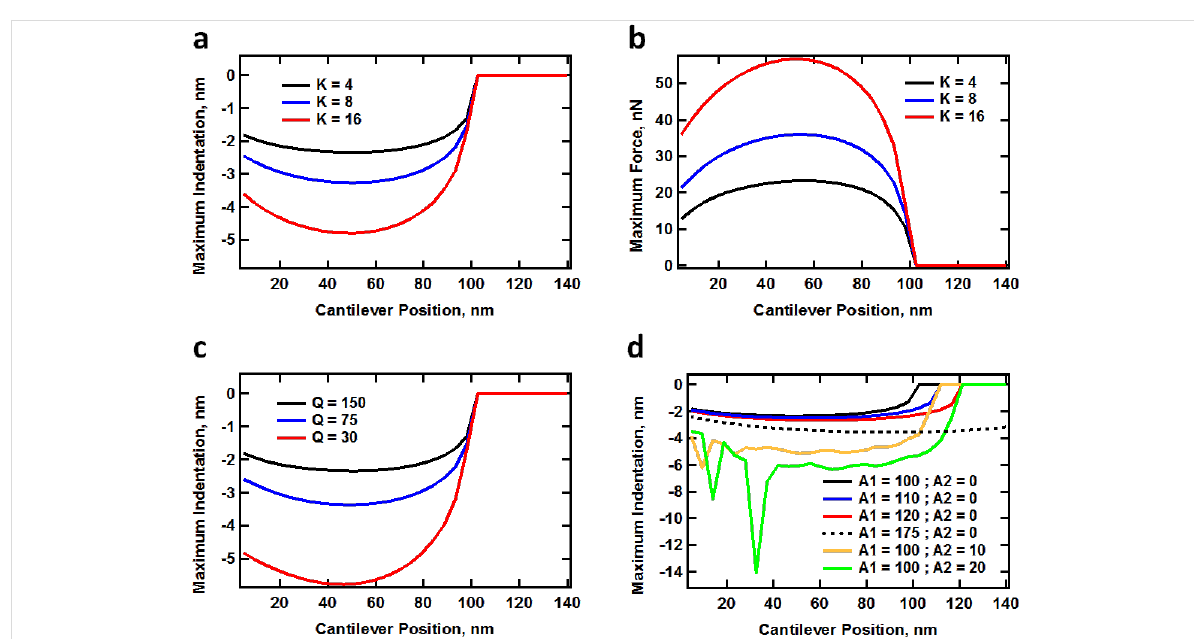
Figure 2: Simulations of maximum indentation and peak force (see section Methods below for details on the numerical simulations of the cantilever dynamics as well as the tip–sample force model used): (a) maximum indentation depth vs cantilever force constant; (b) peak forces corresponding to (a); (c) maximum indentation vs cantilever quality factor, Q (unrealistically low values of Q were chosen to illustrate the effect of high damping); (d) maximum indentation vs first and second eigenmode free amplitudes. The first eigenmode free amplitude in these simulations was 100 nm, unless otherwise indicated. The cantilever and force model parameters are provided in section Methods. The irregular behavior of the indentation for the lowest two traces at small cantilever–sample separations in (d) is a consequence of the non-steady state behavior of multi-eigenmode oscillations